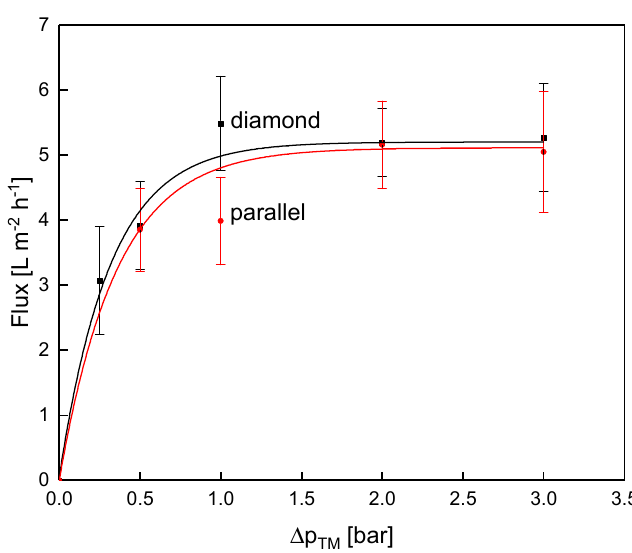
Figure 10. Flux as a function of the transmembrane pressure for the parallel and the diamond spacer during MF of concentrated skim milk (CF 3). Error bars represent the standard deviation of two individual experiments.